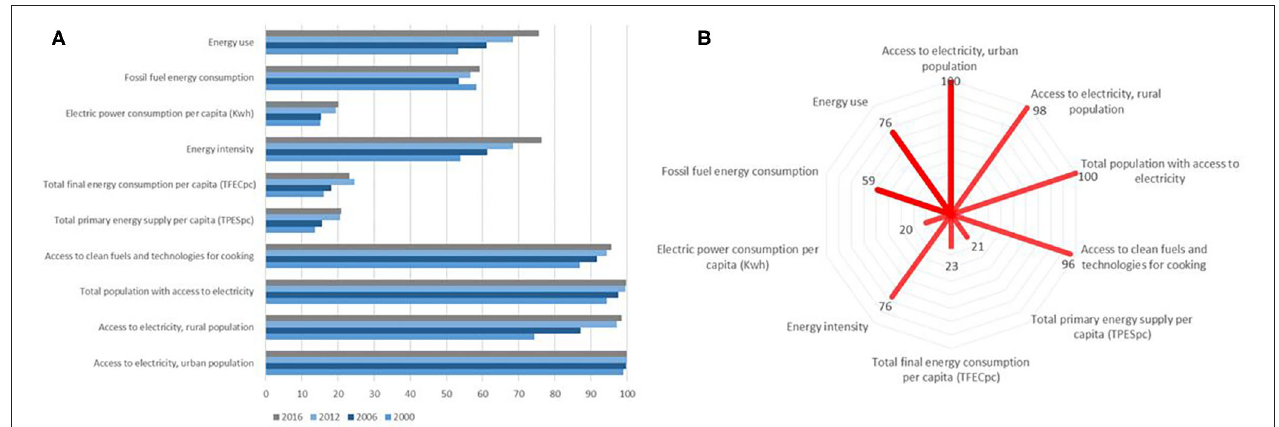
FIGURE 5 | Energy indicators (normalized) — Brazil (2000, 2006, 2012, 2016).